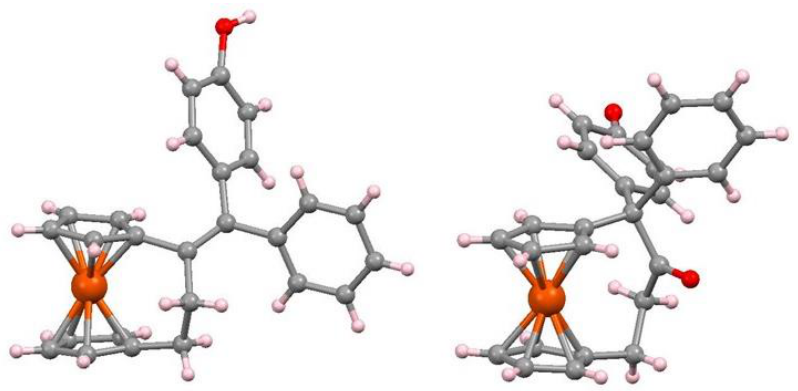
Figure 6. Molecular structures of the ansa -ferrociphenol, 108 , and the pinacolone, 109 .